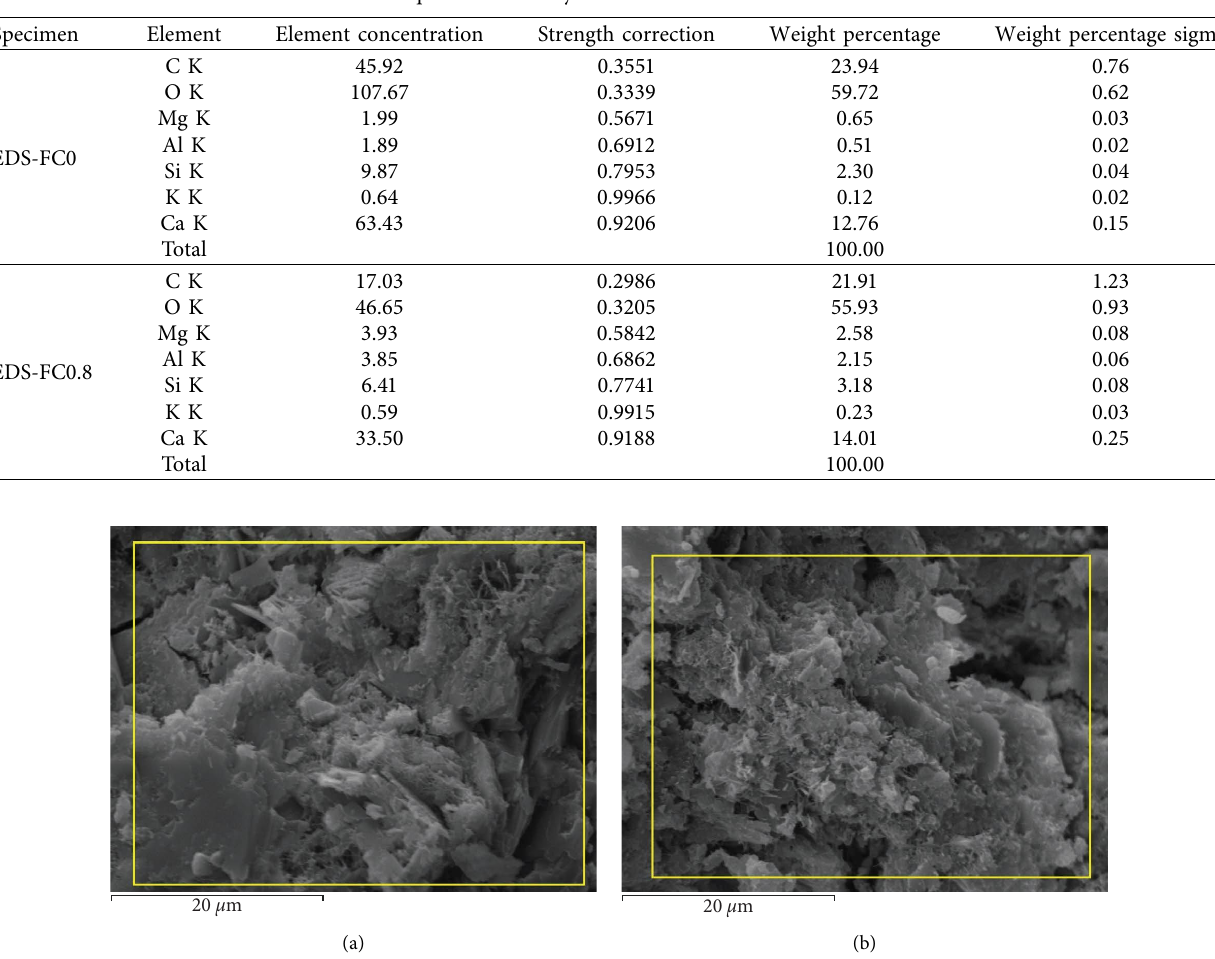
Table 7: EDS quantitative analyses ARGFRC EDS-FC0 and EDS-FC0.8. Specimen Element Element concentration Strength correction